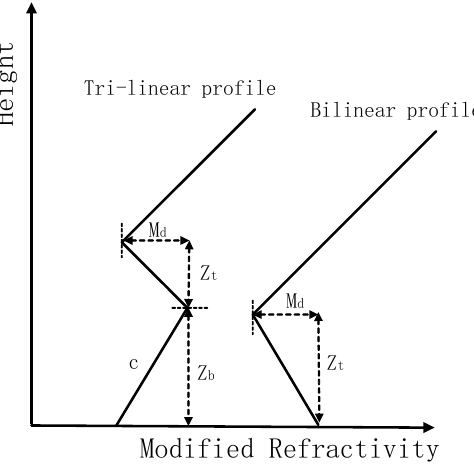
Fig. 1. The sketch map of trilinear profile and bilinear